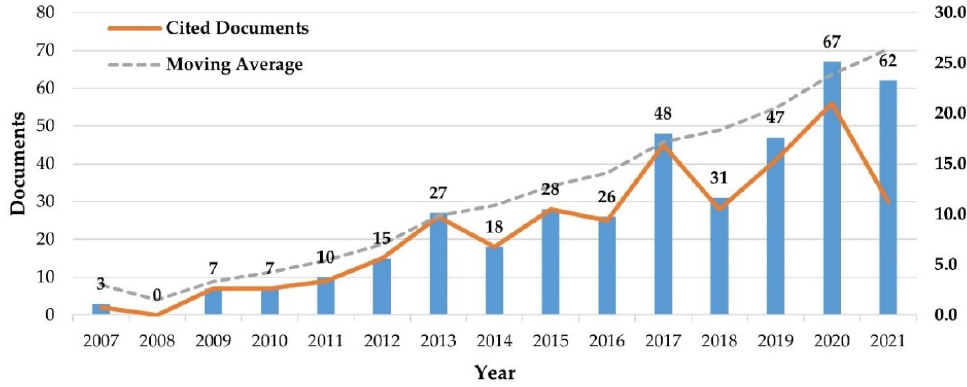
Figure 2. Evolution of scientific production.